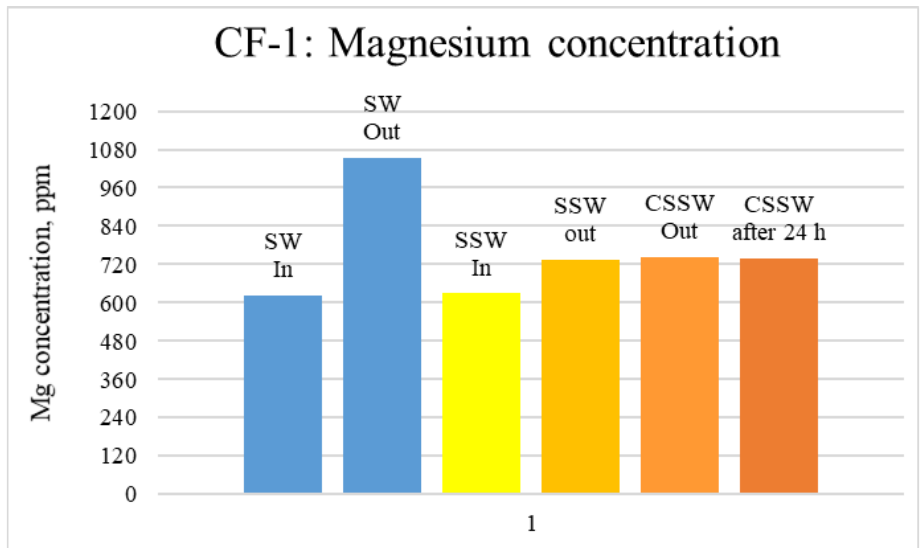
Figure 13. ICP analysis of CF1 brines: Magnesium concentration.